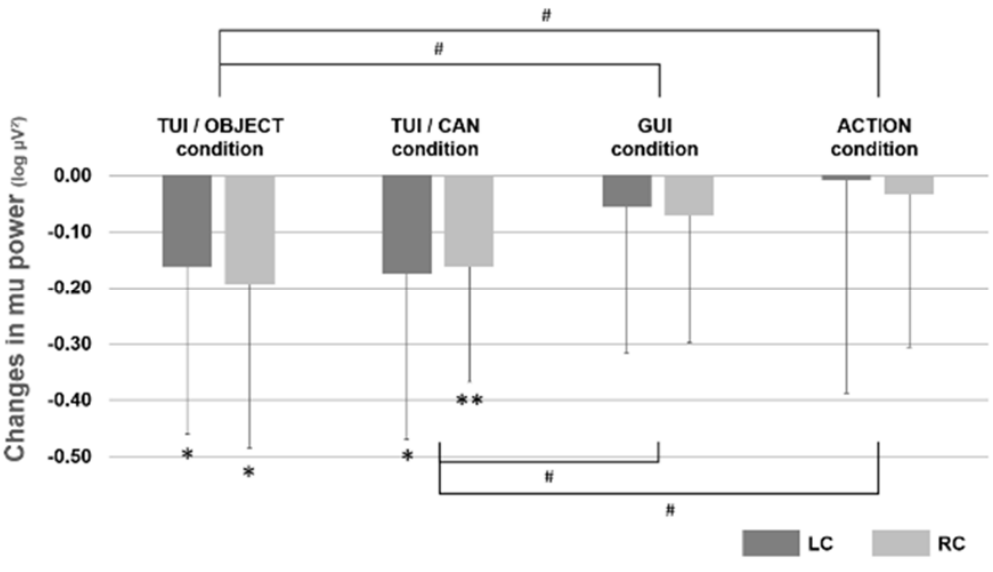
Figure 5. Mu rhythm suppression (LC and RC) in different conditions in Experiment 2. Asterisks (** p < 0.01, * p < 0.05) mean the significant mu rhythm suppression from baseline to observation of each actions. Sharps (# p < 0.05) mean the significant difference between conditions.